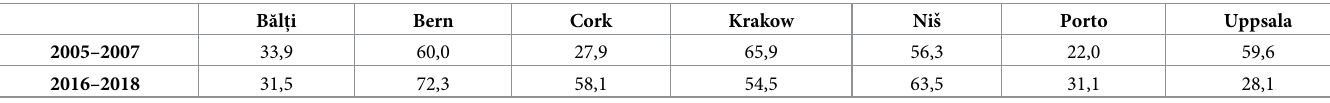
Table 1. Share of questionnaires including drawn course of the Danube in particular cities